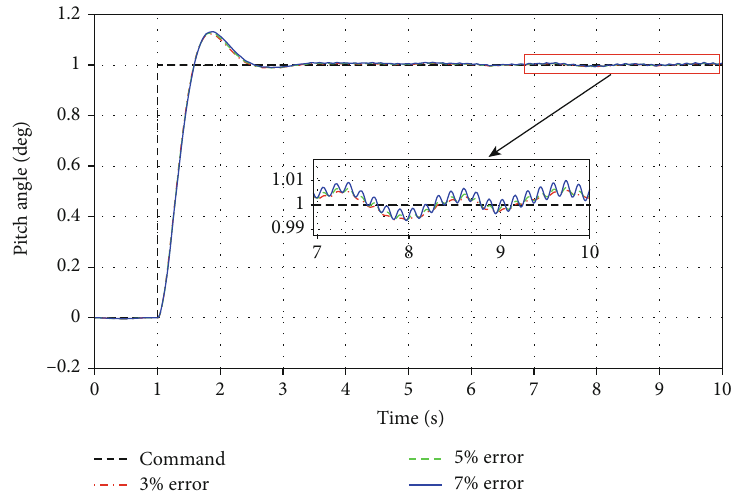
Figure 17: Pitch angle response curves of di ff erent FBG average errors.